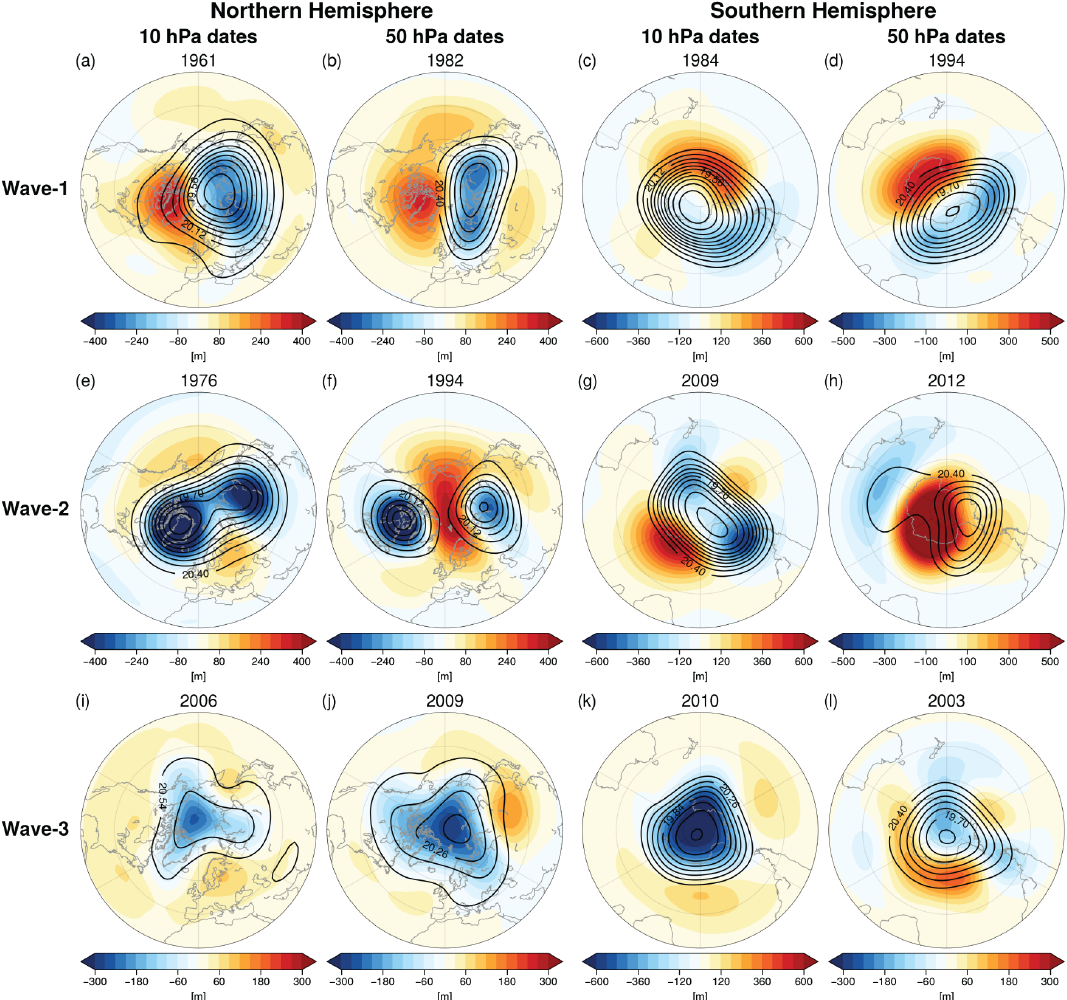
Figure 3. The 50hPa geopotential heights (contours; km) and anomalies (shading; m) from JRA-55 reanalysis averaged over the 10d prior to the final warming for selected case studies that show a clear wave structure for (a–d) wave-1, (e–h) wave-2, and (i–l) wave-3 for both hemispheres and for FSWs dates at both 10 and 50hPa. Note the different color bars.